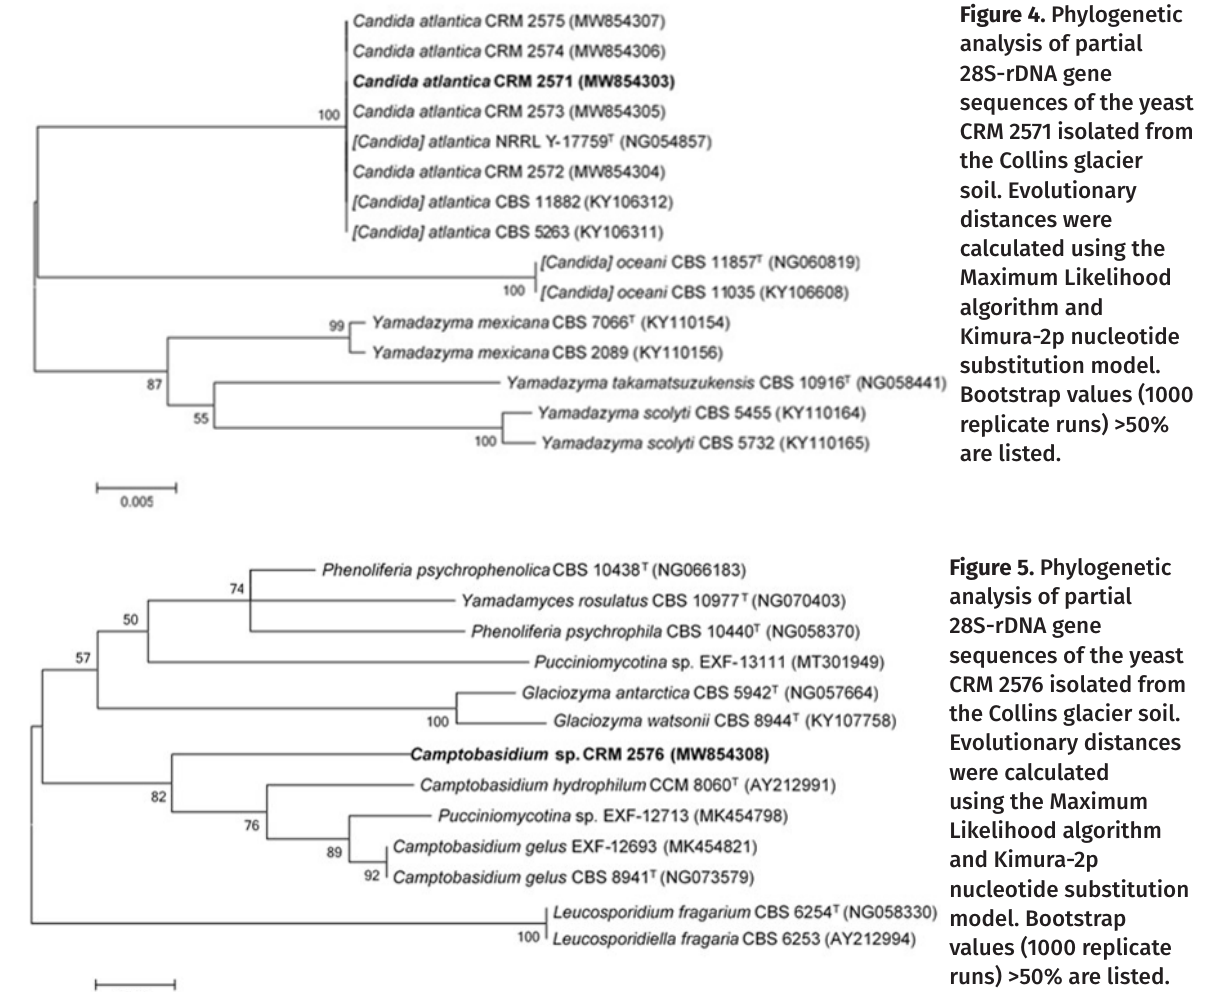
Figure 5. Phylogenetic analysis of partial 28S-rDNA gene sequences of the